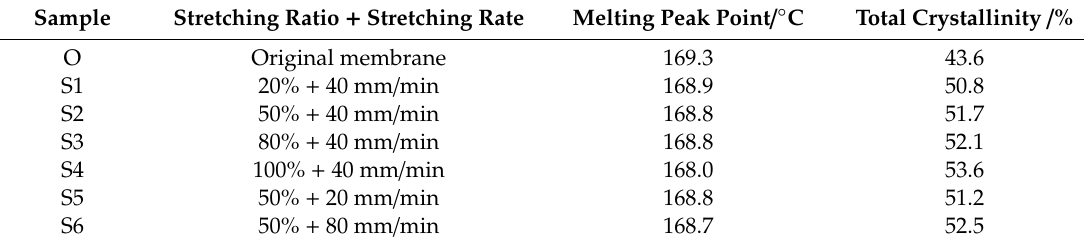
Table 1. The melting points and total crystallinities of polyvinylidene fluoride (PVDF) hollow fiber membrane samples with di ff erent preparation